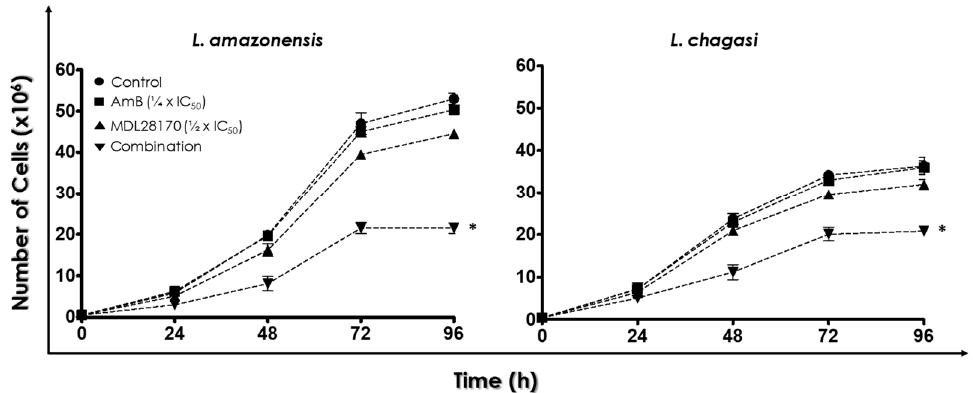
Figure 1. Effects of the combination of 1 / 4 × IC 50 value of amphotericin B (AmB) plus 1 / 2 × IC 50 value of the calpain inhibitor MDL28170 on promastigotes of L. amazonensis and L. chagasi . The growth rate of promastigotes was monitored when the parasites were cultured at 28 ◦ C in the absence (control) or in the presence of both drugs in the combination cited above. In addition, growth rate of promastigotes was monitored in the presence of either the 1 / 4 × IC 50 value of AmB or the 1 / 2 × IC 50 value of MDL28170. The number of viable cells was estimated daily up to 96 h in a Neubauer chamber. Results represent mean ± standard deviation of three independent experiments performed in triplicate. Asterisks mean significant different values when compared to control ( p < 0.05).